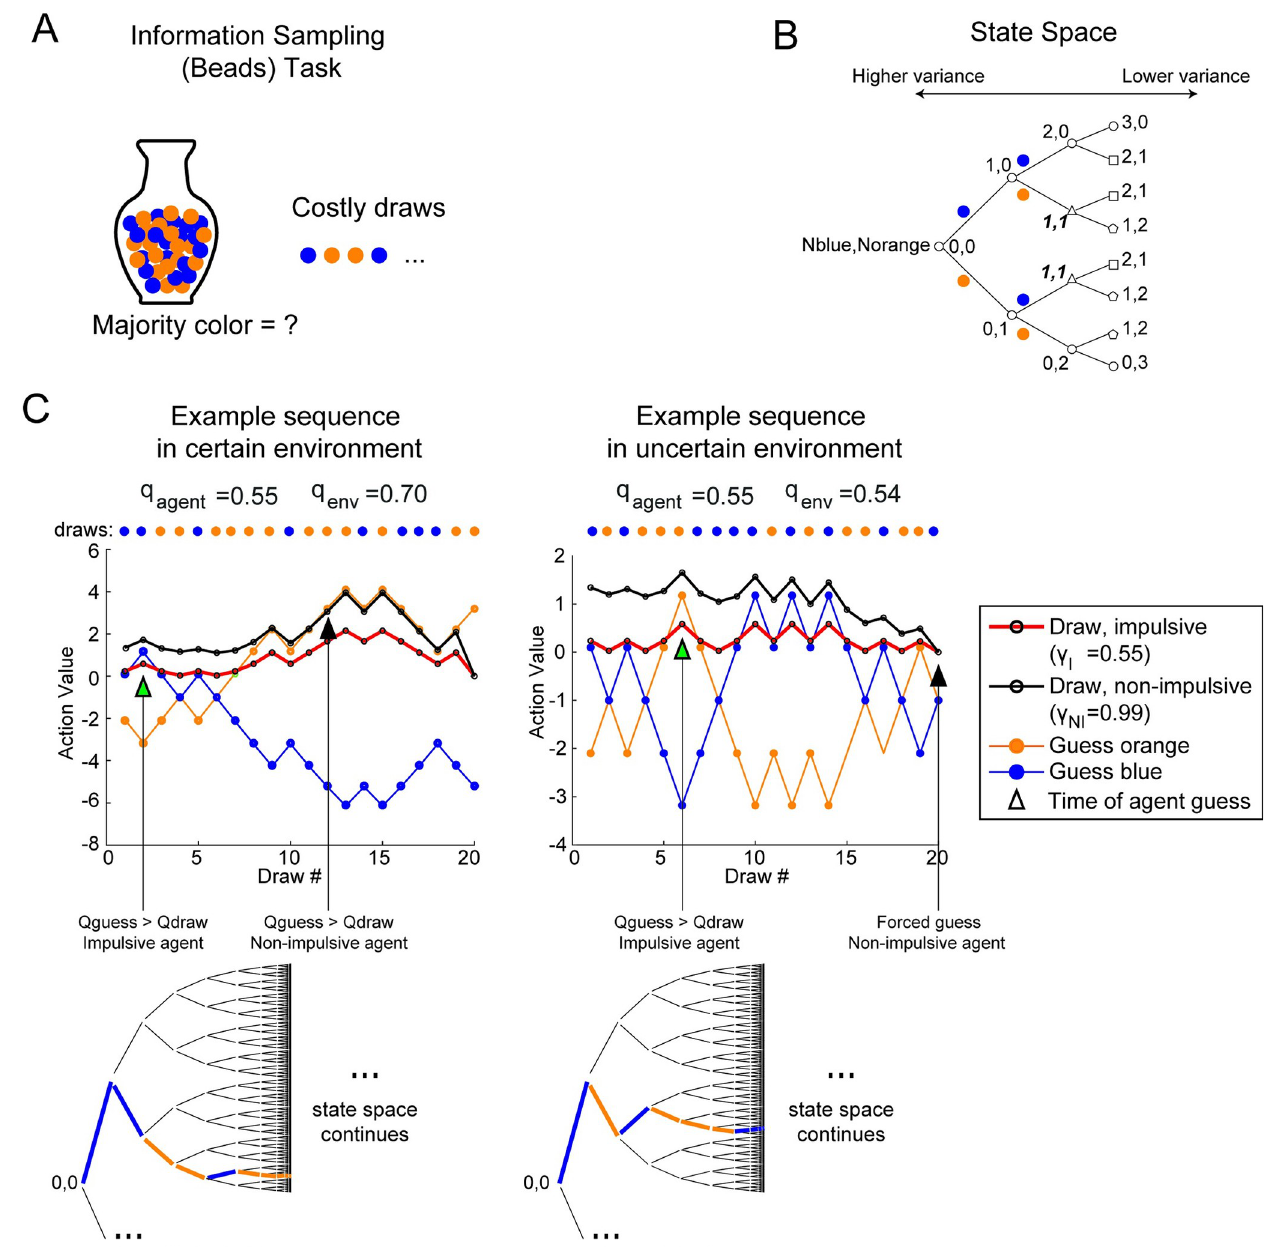
Fig 3. Information Sampling (Beads) Task and examples of agent performance in high and low certainty environments. A) Task schematic for the Beads task. In this task, the objective is to correctly guess the majority color of beads (e.g. orange or blue) in the urn. The participant or agent has the option to draw one bead at a time (for a cost, e.g. $0.10) to accumulate evidence. The agent’s goal is to accumulate sufficient evidence to make a confident guess without incurring maximum draw cost. Once the maximum number of draws is reached, the agent is forced to guess a color. An agent receives a reward for a correct guess (e.g. $10) or a cost for an incorrect guess (e.g. -$12). B) The state space tree for the beads task up to 3 draws. Each node represents the number of orange and blue beads that have been drawn thus far and a decision point, where the agent can either draw again, guess orange, or guess blue. If the agent draws another bead, they stochastically transition to the next state according to a binomial probability. At the start of the tree, the variance in the probability distribution over the majority probability is highest and decreases with increasing numbers of draws. Note that the states with the same number of orange and blue beads after 3 draws are the same state. We draw repeated states as separate for clarity,. Repeated states are illustrated by the shape of the node. Circular nodes are unique, nodes of other shapes indicate a repeated state. C) Two example bead draw sequences in certain and uncertain task environments and the behavior of impulsive and non-impulsive agents. On the left, a sequence of 20 draws is shown from a set of task parameters that creates an environment where there is high certainty the majority color is orange (q agent = 0.55, q env = 0.7, C draw = 0.10, R correct = 10, R incorrect = -12). The plot shows the action values for guessing orange and guessing blue which are identical for both agents. The plot also shows the corresponding action values for drawing a